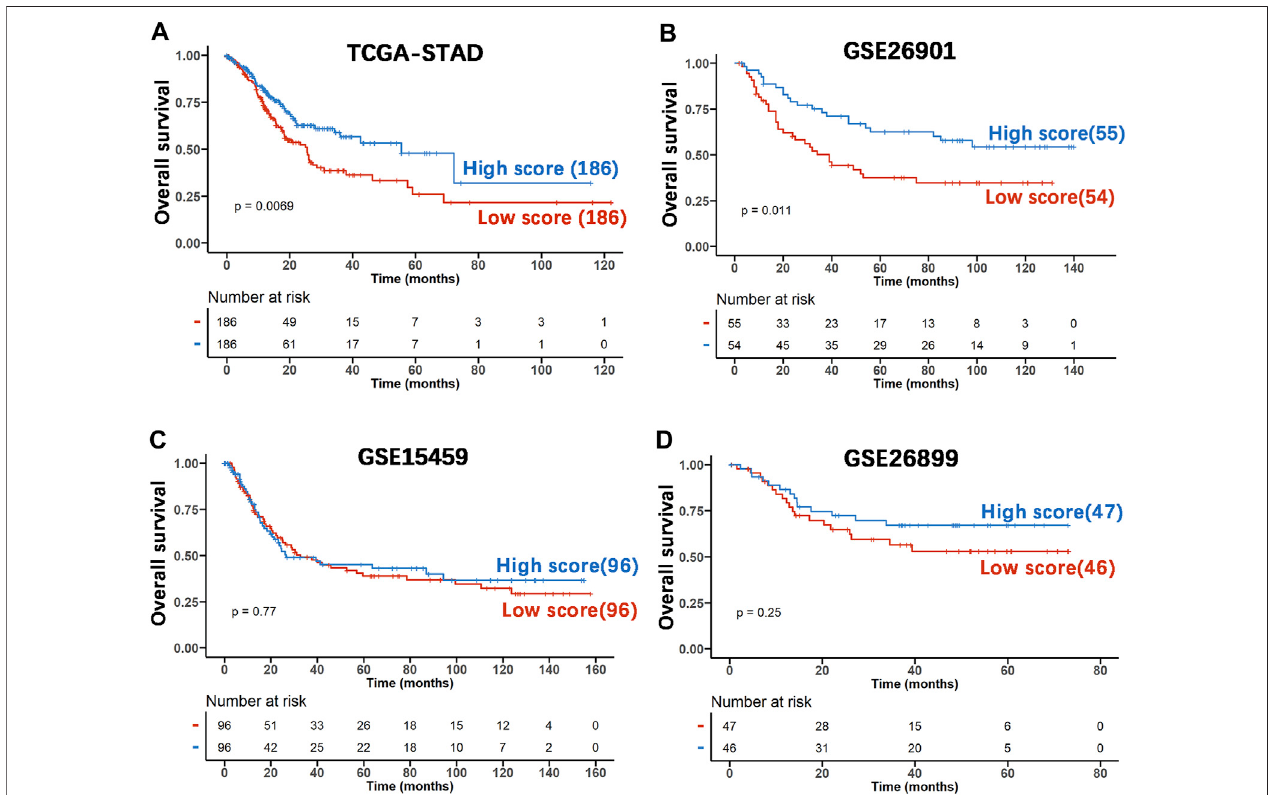
FIGURE 5 | The prognostic capability of the DRGS score system using various publicly available gastric cancer datasets. (A) Kaplan-Meier analysis and log-rank test of TCGA-STAD samples were used to compare the OS rate of the two score groups (High score n = 186, Low score n = 186); (B) The independent gastric cancer datasetGSE26901(Highscore n =55,Lowscore n =54)asthevalidationsetwasanalyzedusingthesamemethodasabove; (C) thedatasetGSE15459(Highscore n = 96, Low score n = 96) was used as the validation set; (D) GSE26899 (High score n = 47, Low score n = 46) was used as the validation set.